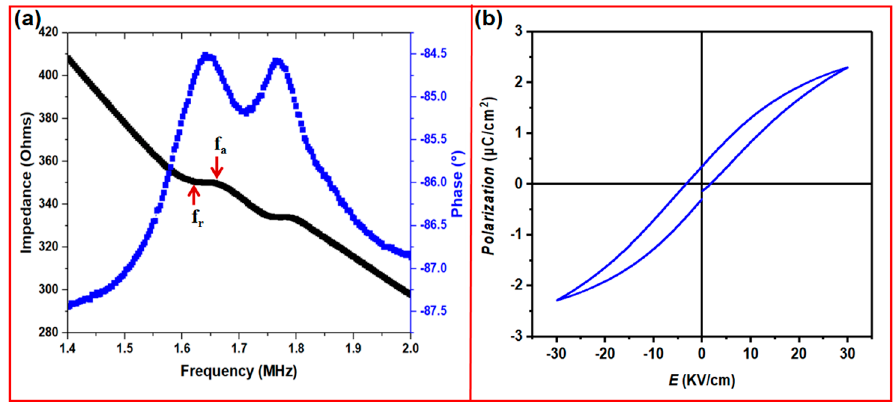
Figure 6. ( a ) Impedance and phase angle spectrum of the sputtered sample. ( b ) Polarization-electric field (P-E) hysteresis loop of the sputtered sample.